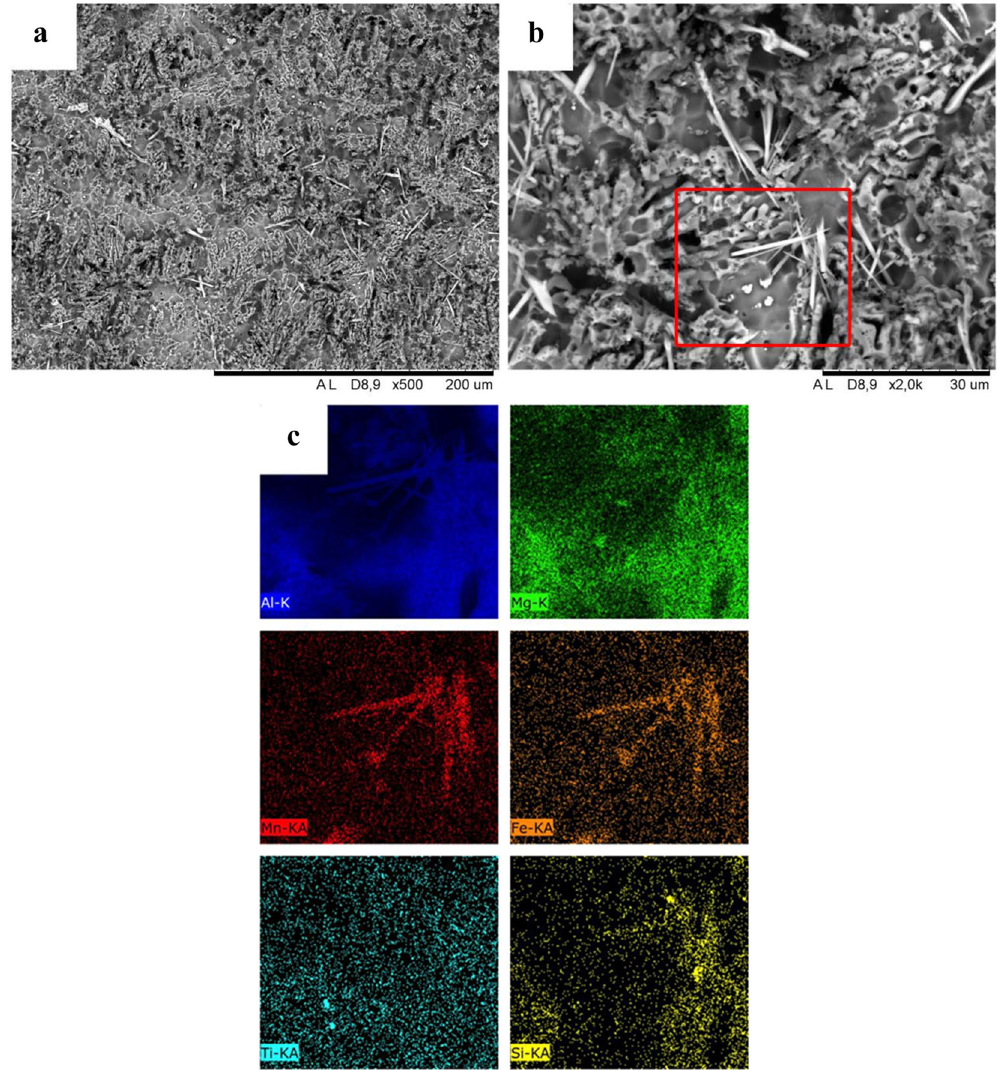
(orange), Ti (cyan), and Si